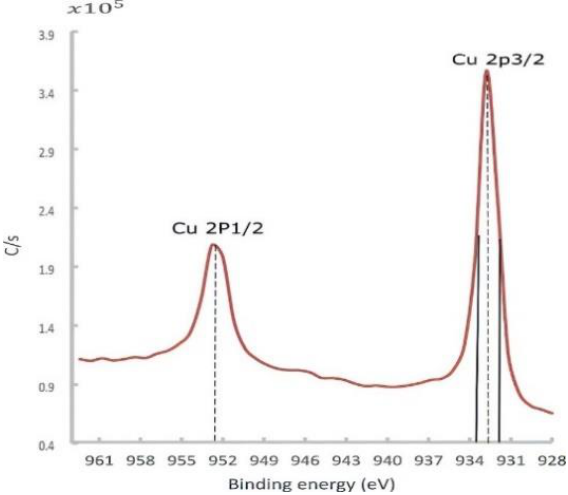
Figure 15. Cu 2px high-resolution spectra for the Cu sample fabricated by L-PBF with a laser power of 370 W, scanning speed of 500 mm/s, and hatch spacing of 0.1 mm, after sputtering.